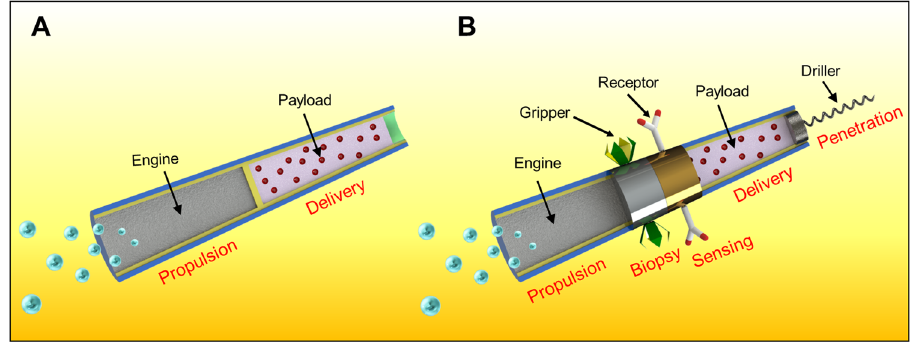
Fig. 1 Strategies in designing microbots. Single-purpose customized nanovehicles ( A ) versus multi-purpose “ all-in-one ” devices ( B ) with different sections used for imparting different functions (delivery, biopsy, sensing and drilling) along with the basic motion